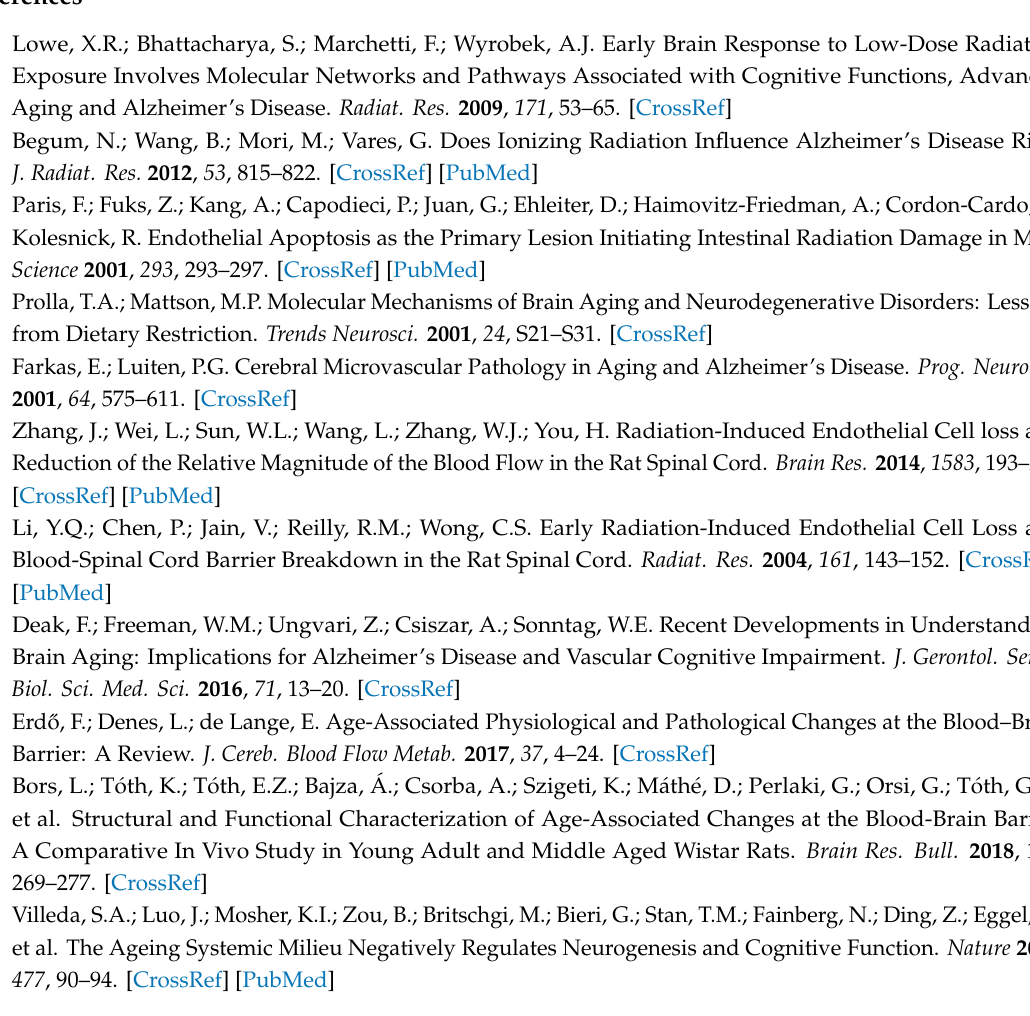
Figure S1: Cell proliferation e ff ect of SDF1 and ATI2341 on HBMVECs. Figure S2: Graph of density measurement of bands in Western